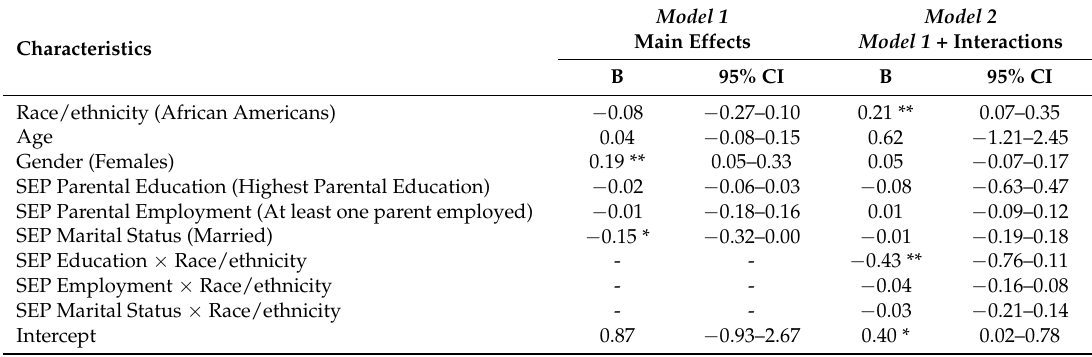
Table 3. Summary of linear regressions between marital status (married parents) at wave 1 and symptoms of anxiety at wave 12 in the pooled